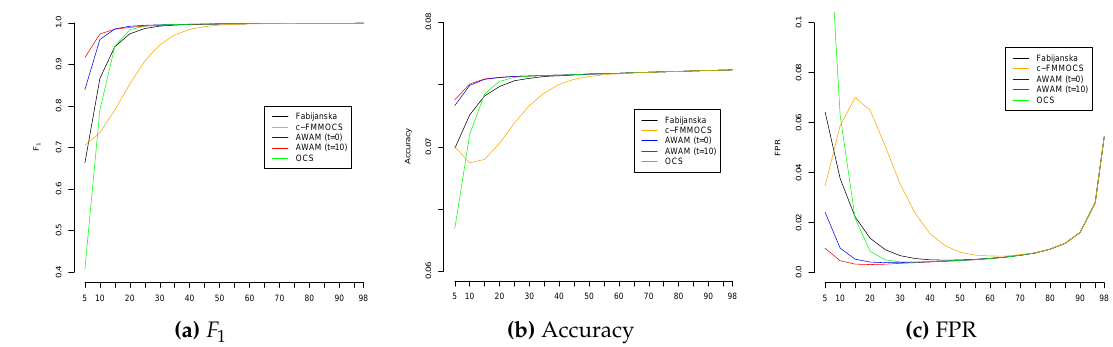
Figure 3. Plots of the means of several measures obtained by the considered noise detection functions versus noise